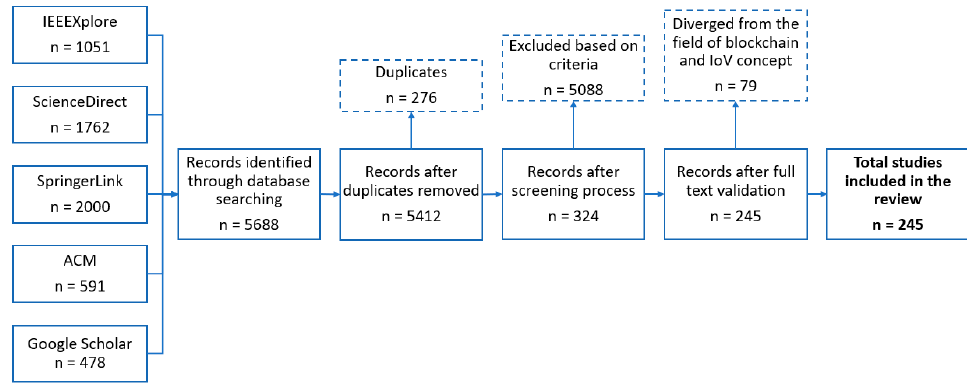
Figure 3. Procedure for identifying selected studies.